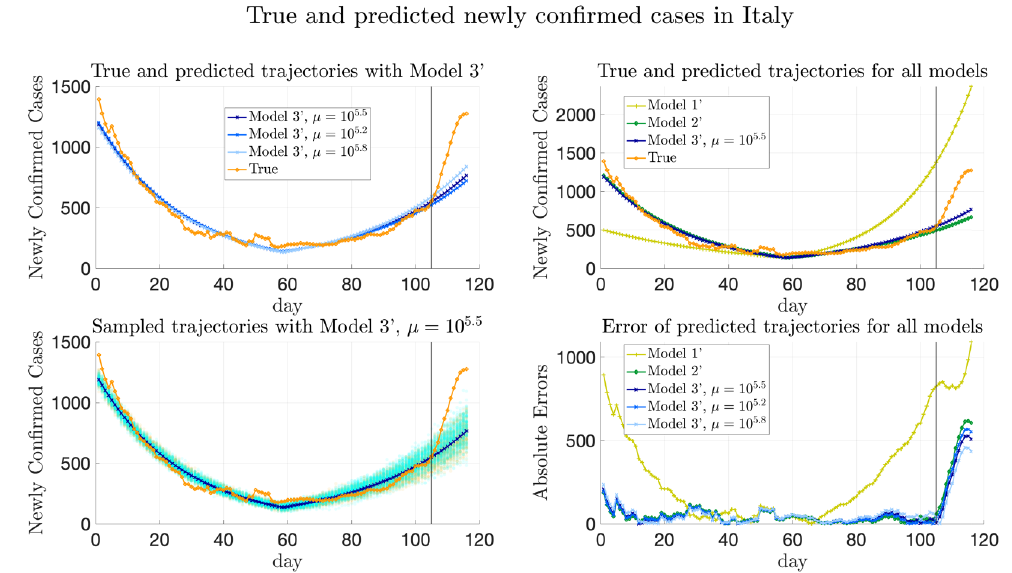
Figure 15. True and fitted trajectories in Italy. The remarks for the lines and scatter plots are the same as those in Fig. 8. The choice of µ = 10 5.2 , 10 5.5 , and 10 5.8 has been explained in Fig. 13.